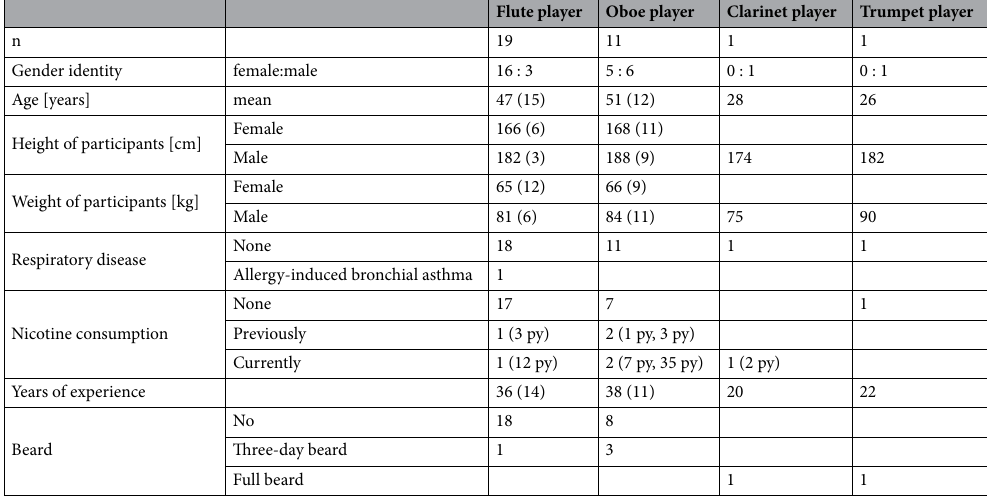
Table 1. Descriptive and demographic data of musicians. Mean (standard deviation) and number of cases are reported. py pack